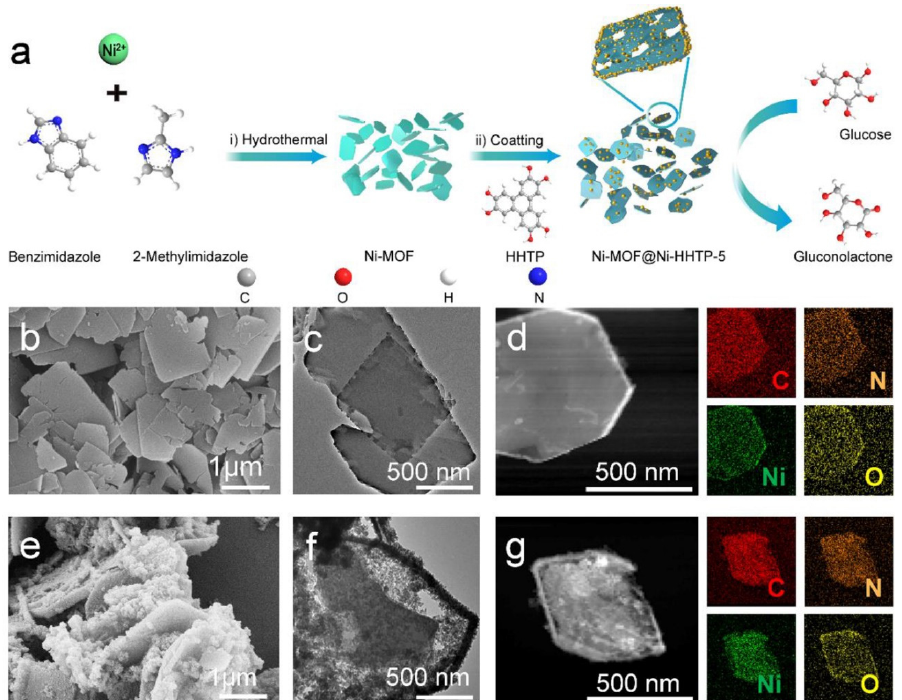
Figure 8. ( a ) Schematic representations of Ni ‐ MOF@Ni ‐ HTTP ‐ 5 synthesis and its glucose biosensing application, ( b , c ) SEM and TEM morphologies of Ni ‐ MOF NS, ( e , f ) SEM and TEM images of Ni ‐ MOF@Ni ‐ HTTP ‐ 5, ( d , g ) STEM and elemental mapping images of Ni ‐ MOF ‐ NS and Ni ‐ MOF@Ni ‐ HTTP ‐ 5 NSs. Reprinted from [28], Copyright (2022), with permission from Elsevier.